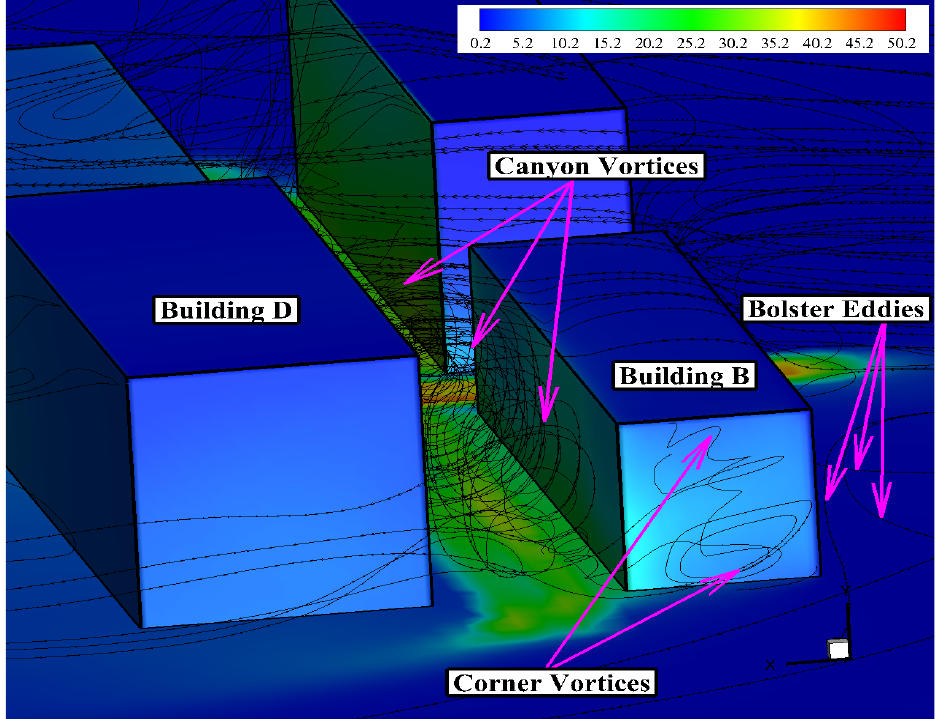
Figure 17. The 3 D streamlines of time-averaged normalized velocity magnitude (cid:104) U (cid:105) / u H and contour of time-averaged normalized pollutant concentrations (cid:104) C